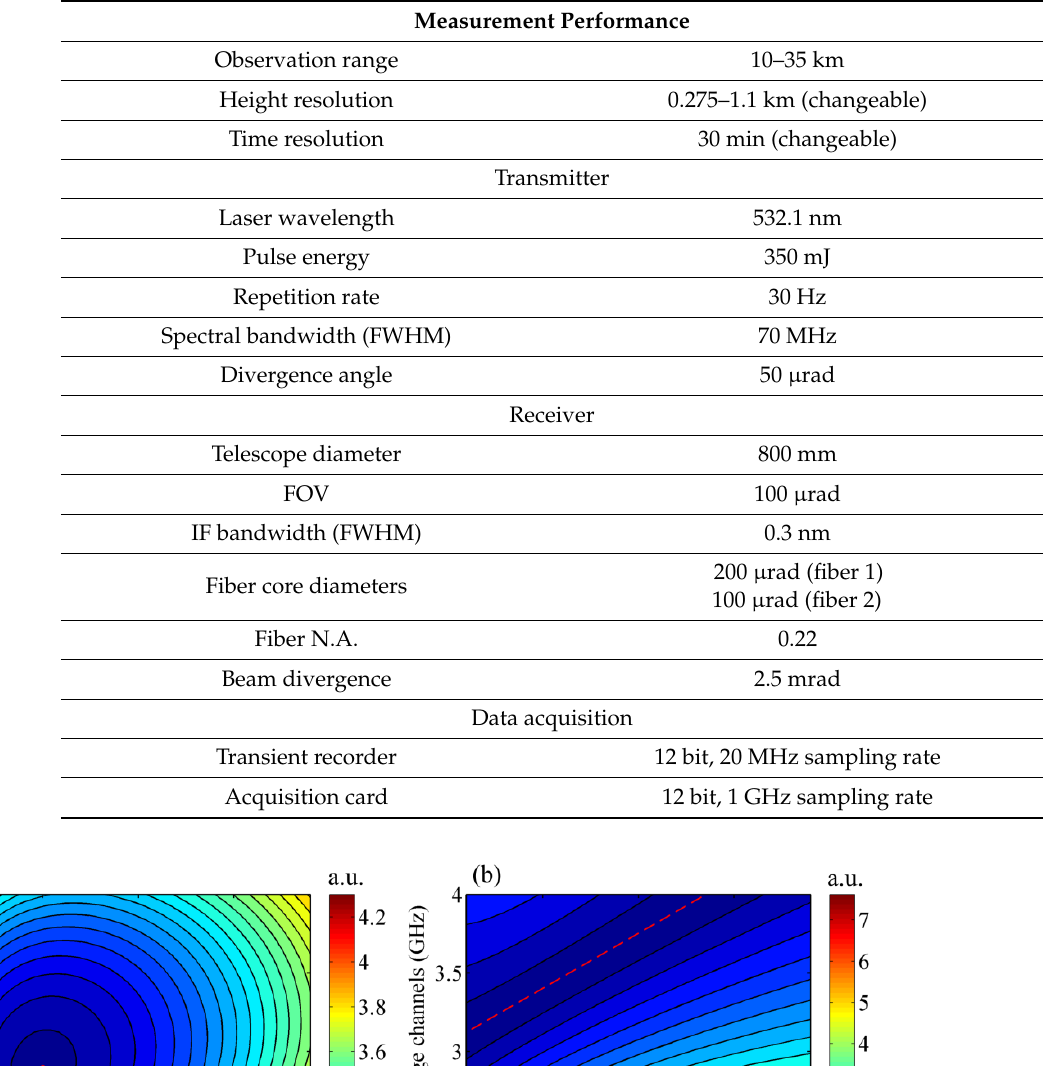
Table 1. Lidar system parameters.